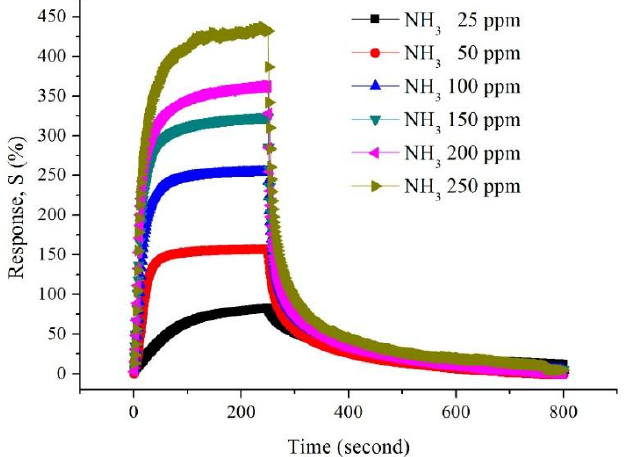
Figure 9. Response of 0.02 M CSA-doped PA6/PANI composite nanofibers to 25–250 ppm NH 3 .